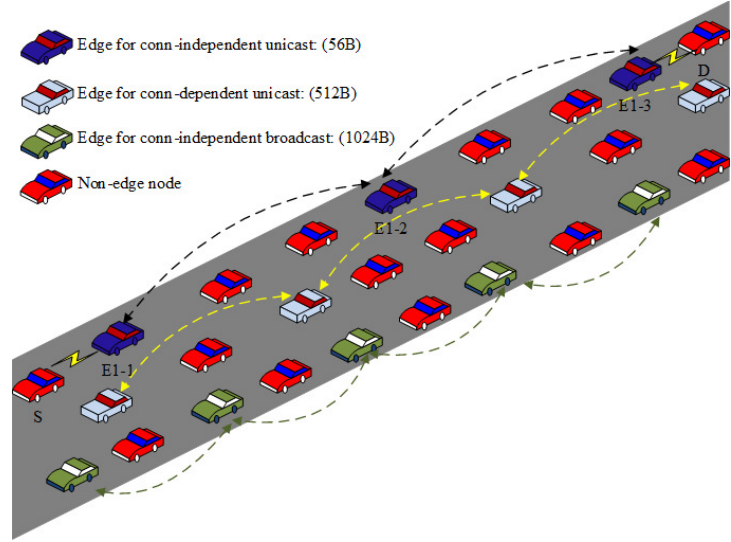
Figure 7. Context-aware edge